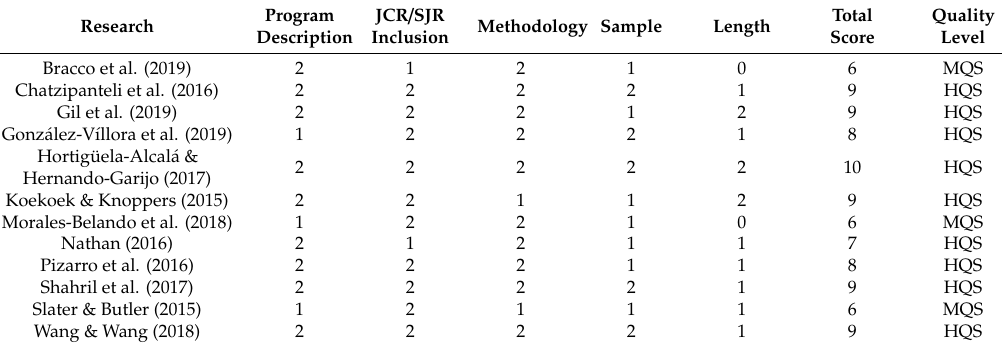
Table 1. Investigation quality score checklist.